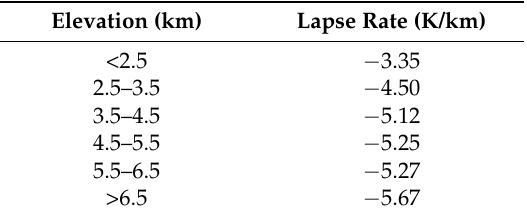
Figure 10. Temperature lapse rate derived from the station observed, CLDAS and remote sensing based daily Ta. Table 2. Temperature lapse rate at different elevation bands derived from the remote sensing based daily Ta.